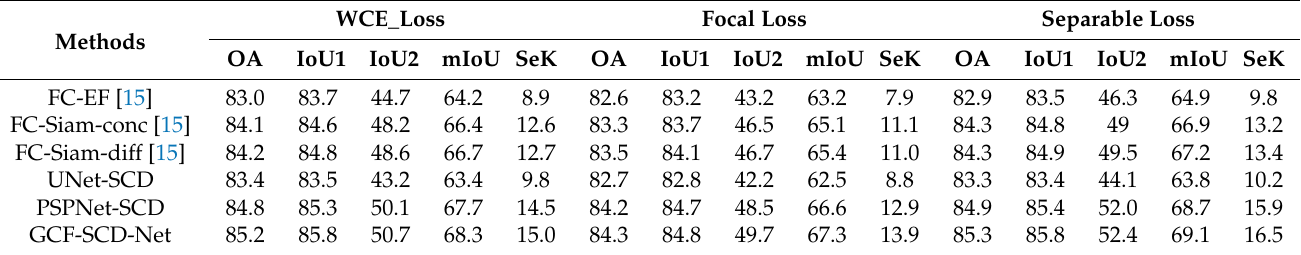
Table 5. Comparison of the change detection networks with different loss functions (% for all except seK).